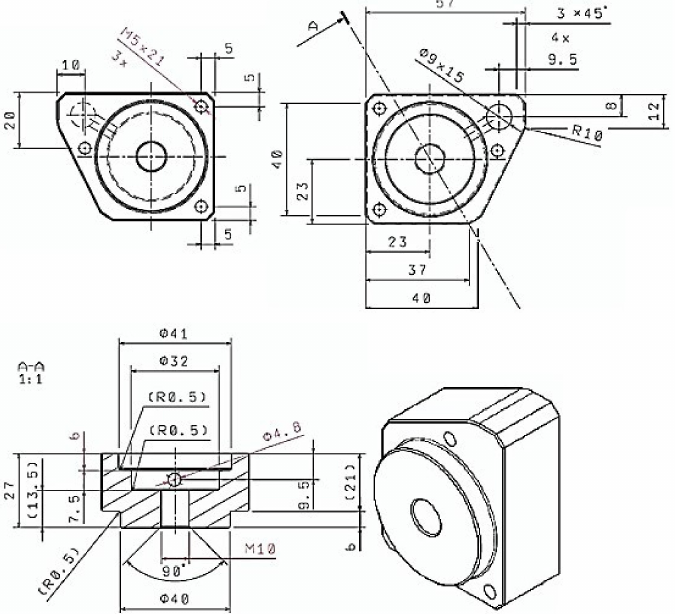
Figure 4. The exact cylinder head geometry used to build a real engine prototype to verify its